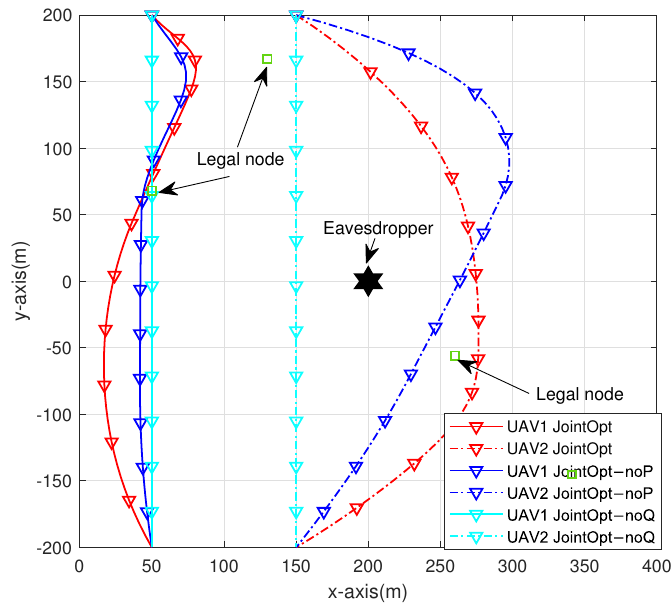
Figure 3. UAV trajectories of different